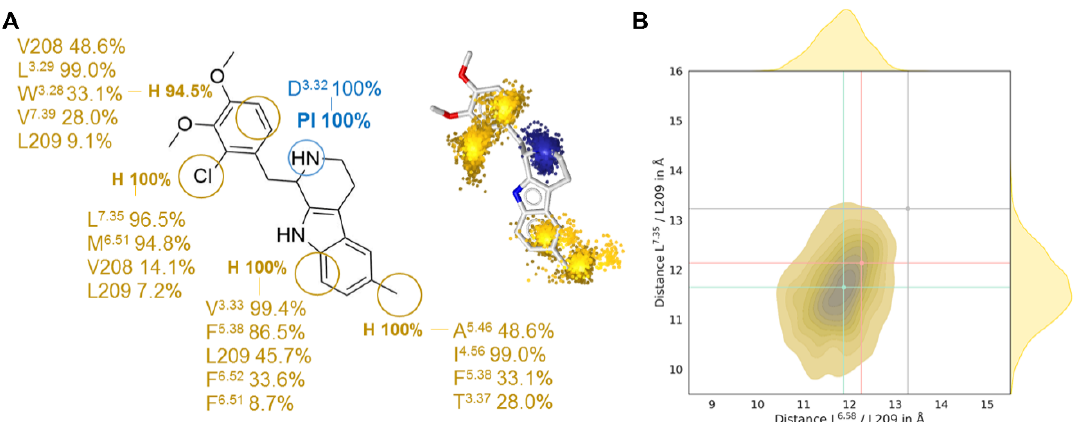
Figure 4. MD-based analysis of Gq-biased 5-HT 2B R agonist LY266097. Dynophore analysis ( A ) shows two key areas for lipophilic contacts (yellow) and one positive ionizable area (blue) in the orthosteric binding pocket. The density plot ( B ) of the C α distances between L209 and L 6.58 and L 7.35 indicate a stronger closure of the binding pocket compared to LSD and ergotamine-bound receptor simulations, whose medians are marked in red and grey. The median of the simulation with endogenous ligand 5-HT bound is shown in green and represents a comparably strong closure of the binding pocket to LY266097.